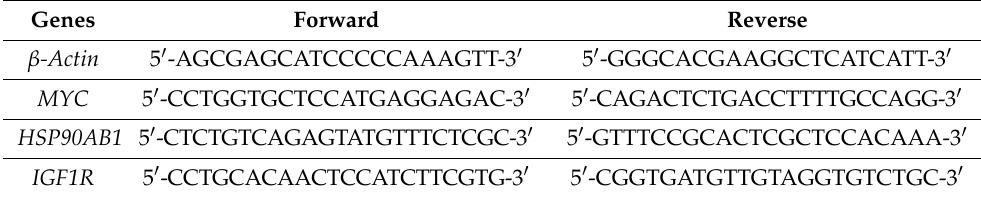
Table 1. Primers of the human genes used in the study.